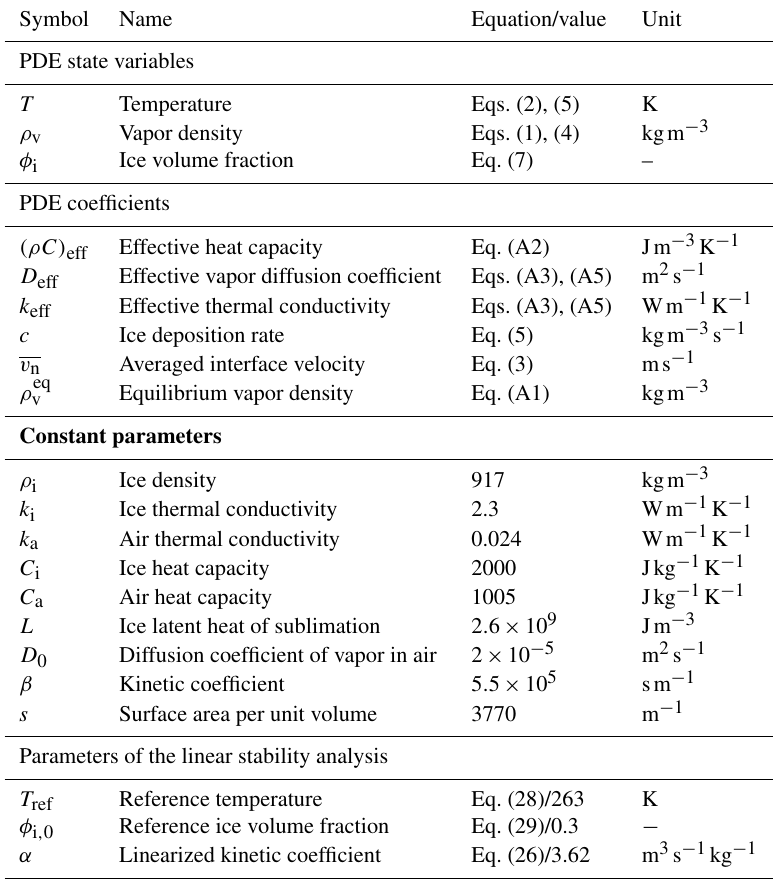
Table 1. Symbols, defining equations and constants used in this